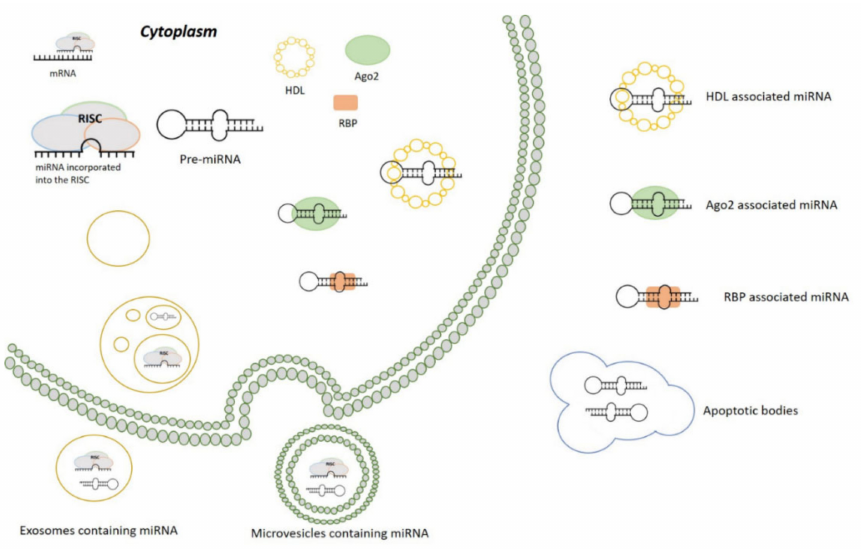
Figure 2. microRNA release mechanisms. miRNAs can be released into the extracellular space through several mechanisms: both pre-miRNAs and mature miRNAs, loaded into the RISC complex, can be incorporated into exosomes or microvesicles and secreted from the donor cell. Circulating miRNAs can also be derived from apoptotic bodies. Moreover, miRNA can be stable in biological fluids in association with RNA-binding proteins (RBP), Ago2 or